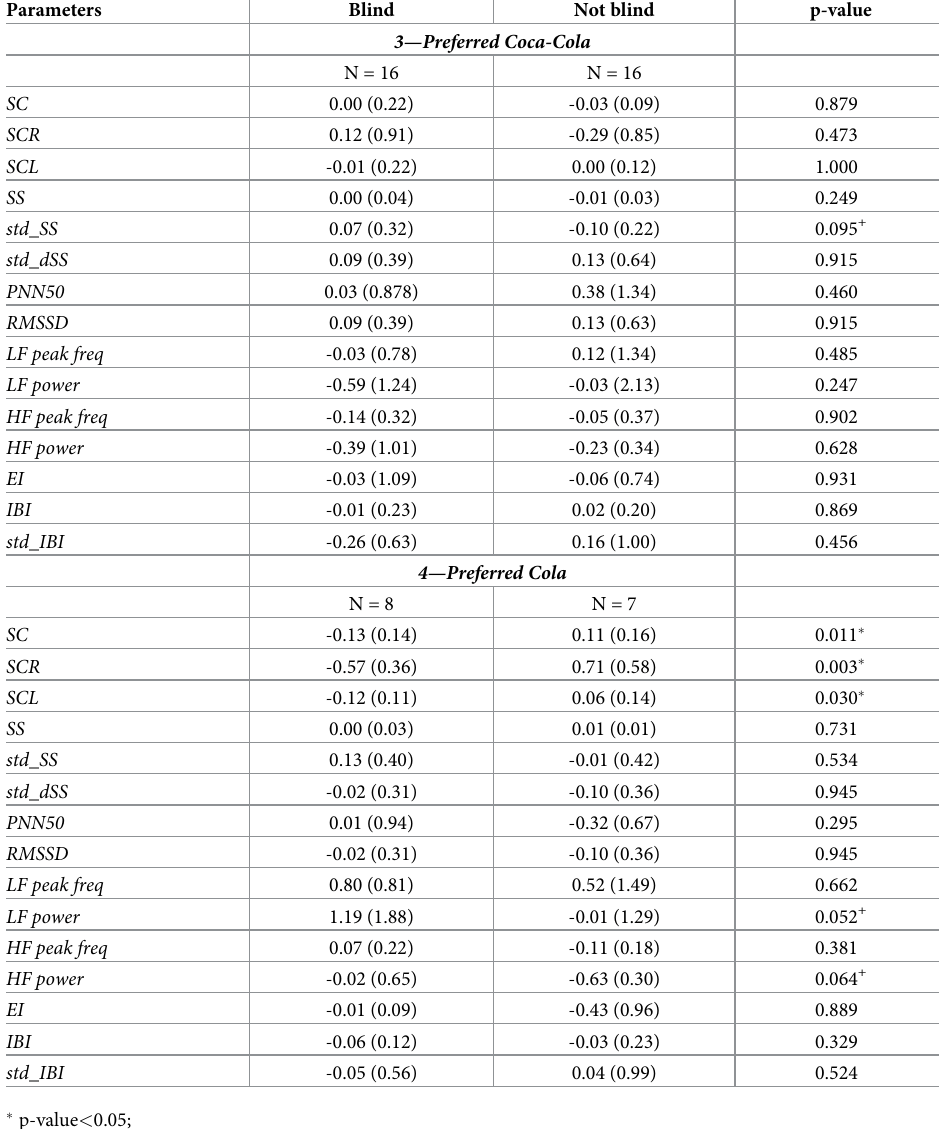
Table 2. Comparison between B and NB conditions—Second